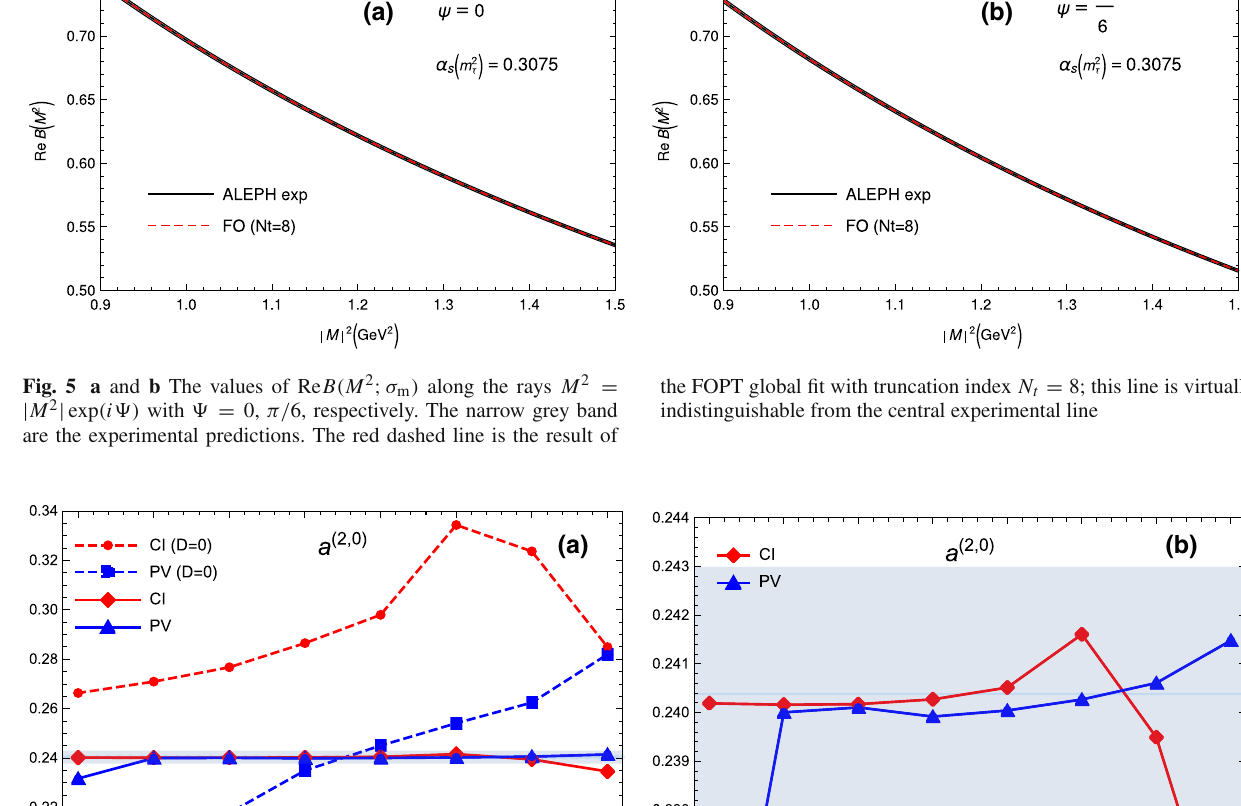
the results where the condensate values are set equal to zero (but α s values are those used for the full results). b The zoomed version for better visibility. The blue band is the experimental band